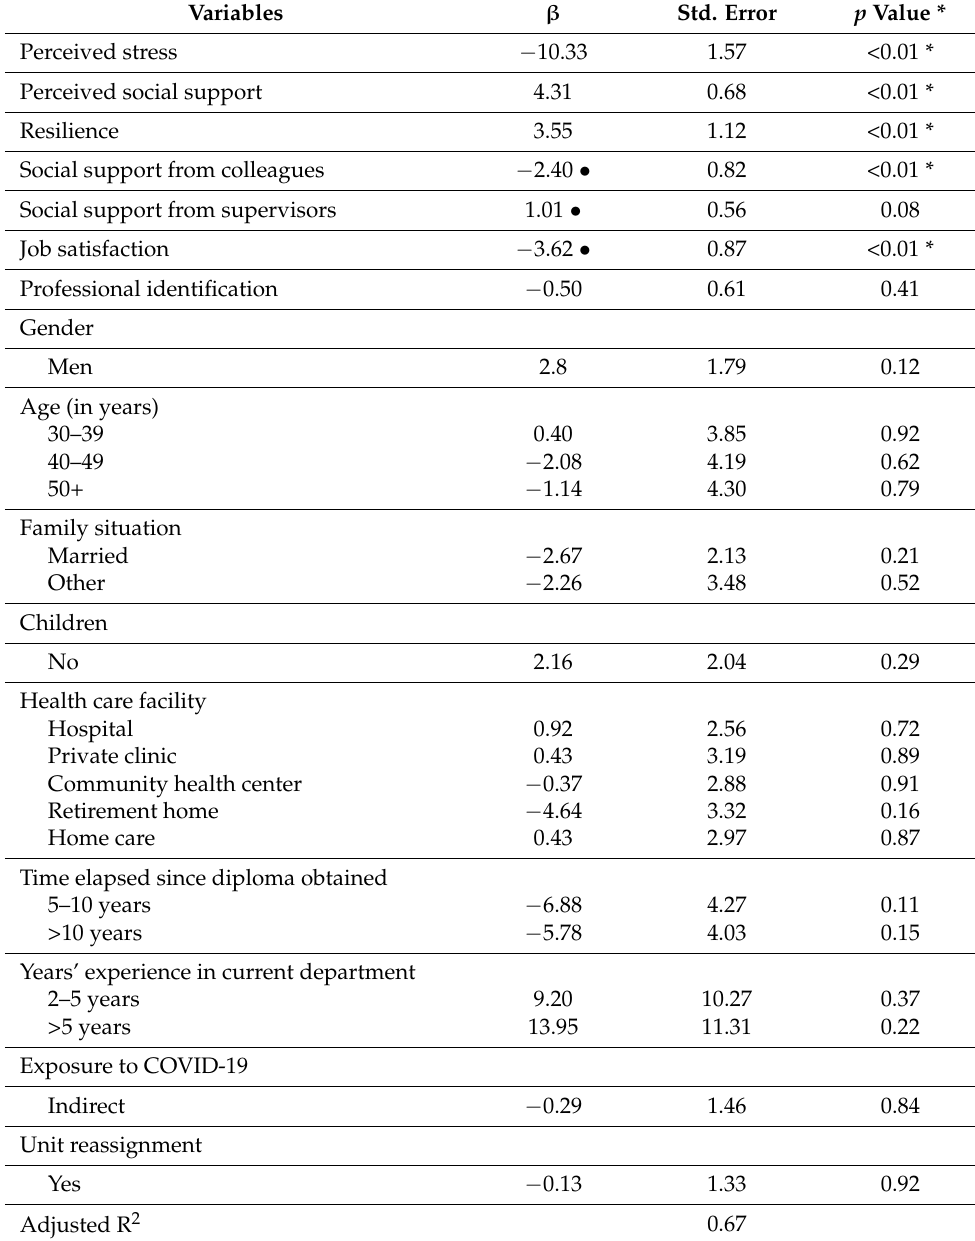
Table 3. Association between stressors/protective factors and quality of life (regression model). Variables β Std. Error p Value * Perceived stress − 10.33 1.57 <0.01